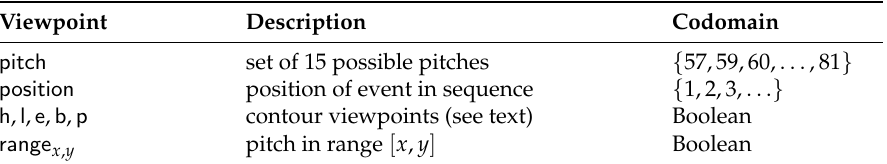
Table 1. Viewpoints used in this